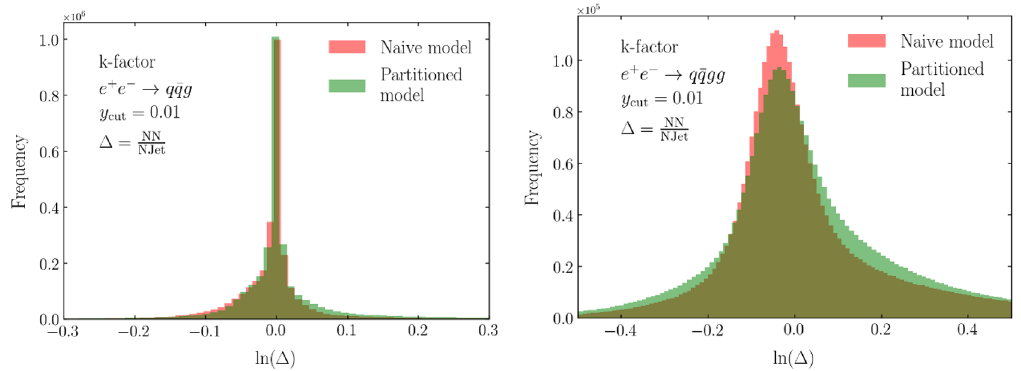
Figure 6 . k-factor output of the naive approach (red) and the partitioned approach (green) com- pared to the Njet calculation at di(cid:11)erent multiplicities. Outputs are taken as the average over 20 trained models.